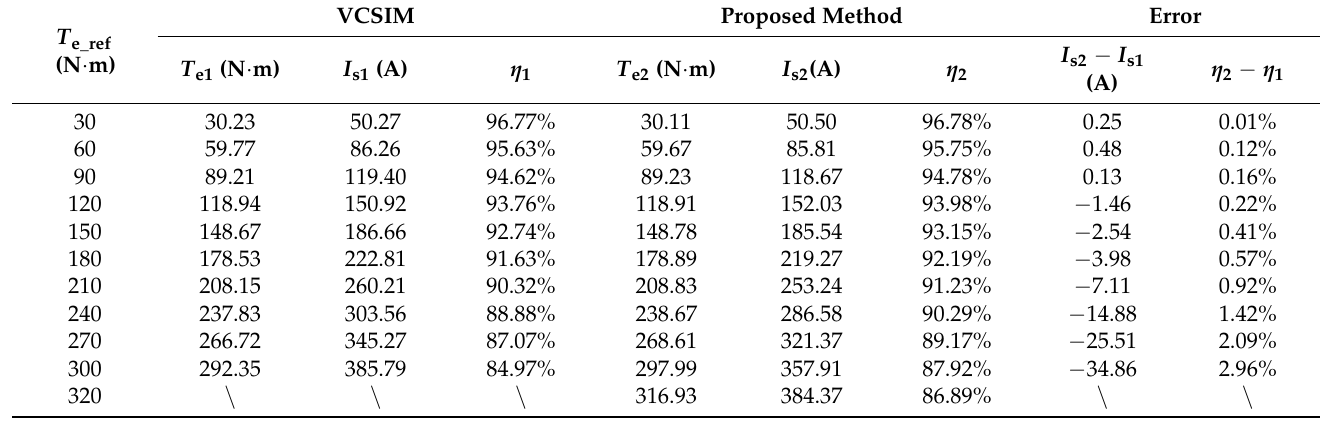
Table 2. Output torque, current amplitude and efficiency when applying VCSIM and the proposed method.